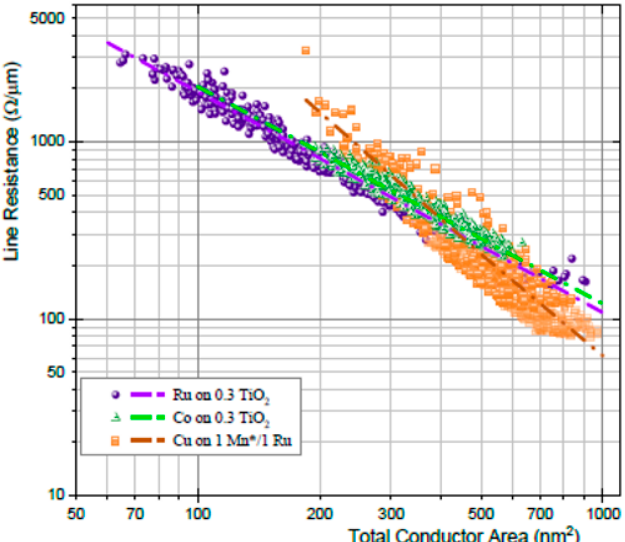
Figure 21. Damascence line resistance vs. the total conductor area of Ru, Co, and Cu NWs